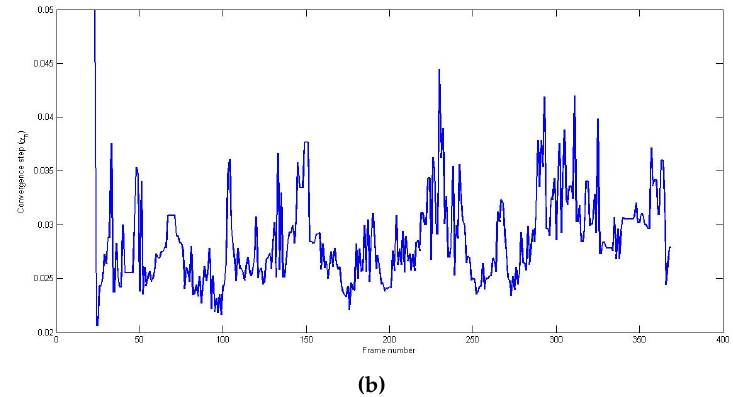
Figure 4. ( a ) Peak signal-to-noise ratio (PSNR) as a function of the frame number for different values of α max ( b ) convergence step α n of the registration-based correction.